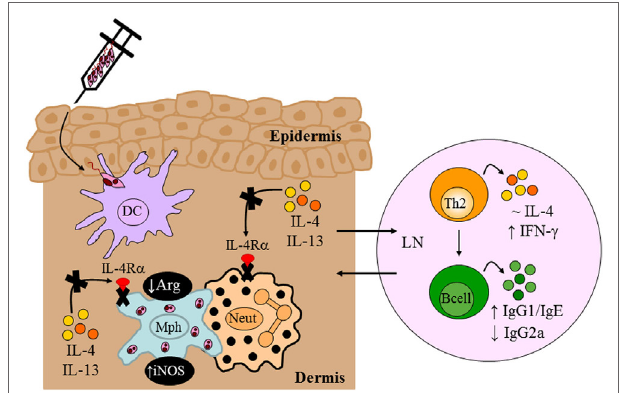
FiGURe 6 | Immune response in BALB/c mice deficient for interleukin-4 receptor alpha (IL-4R α )-responsive macrophages/neutrophils. Despite delayed disease progression in the footpads of L. major LV39-infected LysM cre IL-4R α − /lox mice, unimpaired Th2/type II responses and reduced IgG2a were detected, similar to control BALB/c mice. The absence of IL-4R α - responsive macrophages led to increased inducible nitric oxide synthase (iNOS) and reduced arginase, reflecting a shift to classically-activated macrophages likely as a consequence of increased IFN- γ compared to littermate control BALB/c mice. Illustration prepared from Hölscher et al. (13). DC, dendritic cells; Mph, macrophage; LN, lymph node; Th2, T helper